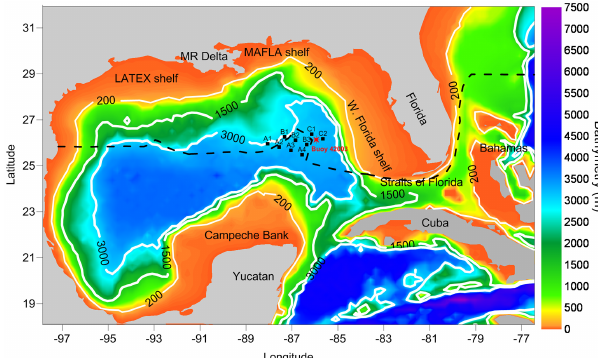
Figure 1. The Gulf of Mexico (GoM) bathymetry (contours in m) and GoM-HYCOM model domain. Black square dots mark the tall mooring deployment sites. The red star indicates the NOAA 42003 Buoy. White lines are the 200, 1500, and 3000m isobaths. The black dashed line is the US–Mexico boundary of the exclusive